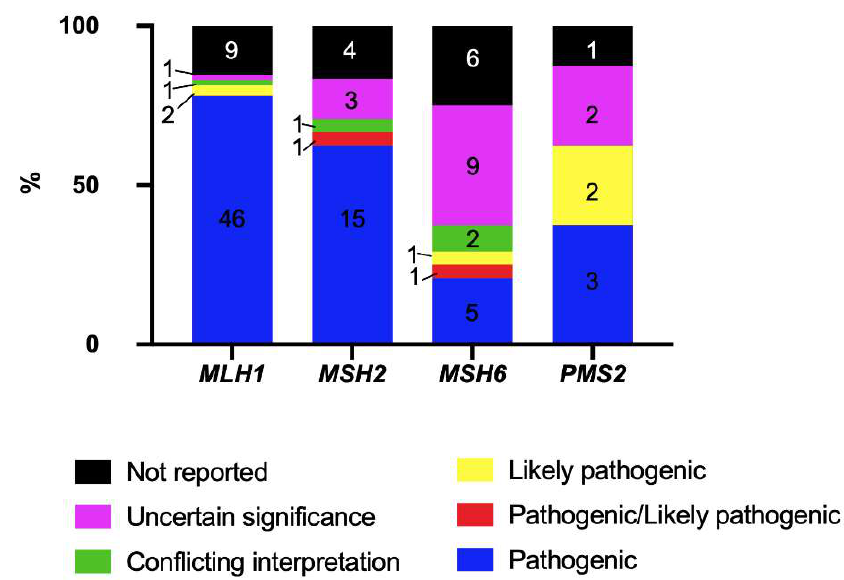
Figure 3. ClinVar classification of MMR variants identified in the cohort. The number in the bars represents the number of variants identified by classification per gene. Table 4. Socio-demographic and histopathological characteristics of the cohort of patients with pathogenic variants (PV) in one of the MMR